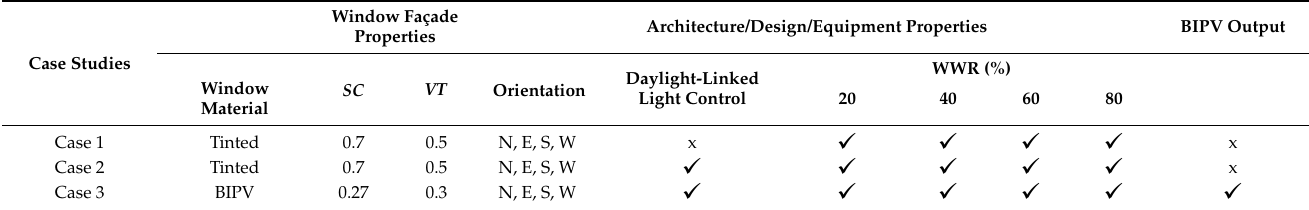
Table 2. Proposed case studies and scenarios based on different WWR.